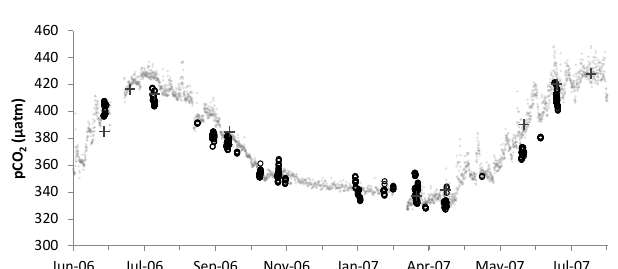
Figure 5. Seawater p CO 2 values from BTM MAPCO 2 (gray points), Bermuda Atlantic Time-series Study (BATS) discrete (plus signs), and R/V Atlantic Explorer underway (open circles) used in the Table 5 statistics. BATS data from Bermuda Institute of Ocean Sciences, bats.bios.edu. Atlantic Explorer data from Bermuda Insti- tute of Ocean Sciences, http://cdiac.ornl.gov/oceans/CARINA/.